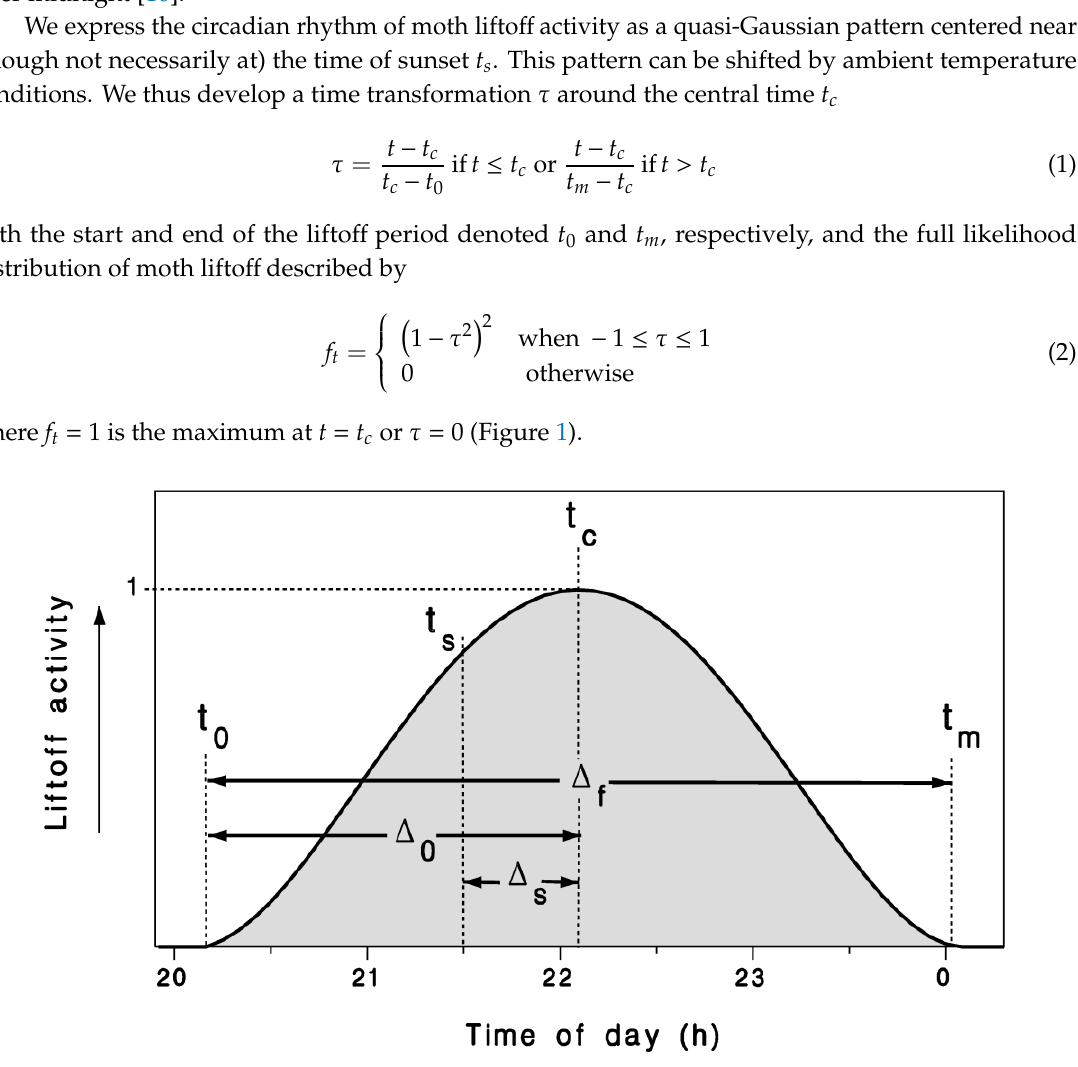
Figure 1. Circadian model of crepuscular migration liftoff activity (Equation (2)) illustrating terms used to define τ in Equation (1), with t s : Time of sunset; Δ s : Time between sunset t s and peak flight t c ; Δ 0 : Time between first flight t 0 and peak flight t c ; Δ f : Duration of the migration liftoff period; and t m : End of flight period.